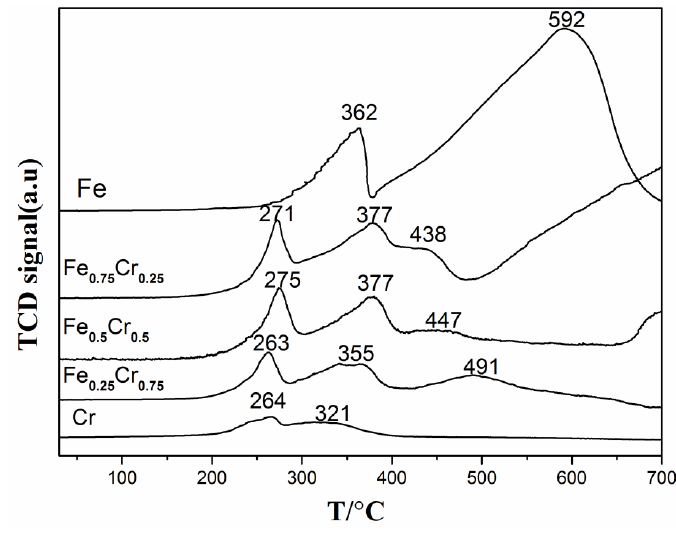
Figure 10. H 2 -TPR profiles of FeCrO x catalysts. Table 7. H 2 -TPR reduction temperatures ( T R ) and temperatures at 50% NH 3 conversion ( T 50 ) of FeCrO x catalysts.